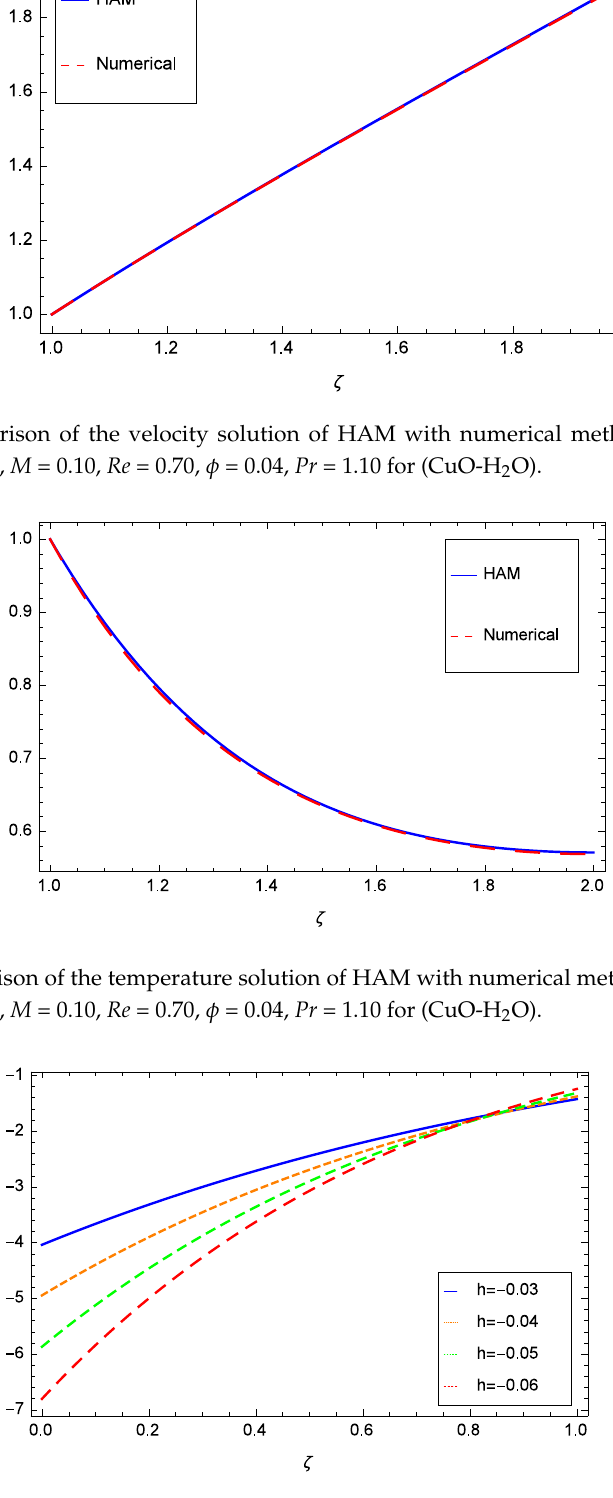
Figure 20. Residual errors sketch of the velocity solution of HAM when β 1 = 2.00, M = 0.10, Re = 0.70, φ = 0.04, Pr = 1.10 and various values of h for (CuO-H 2